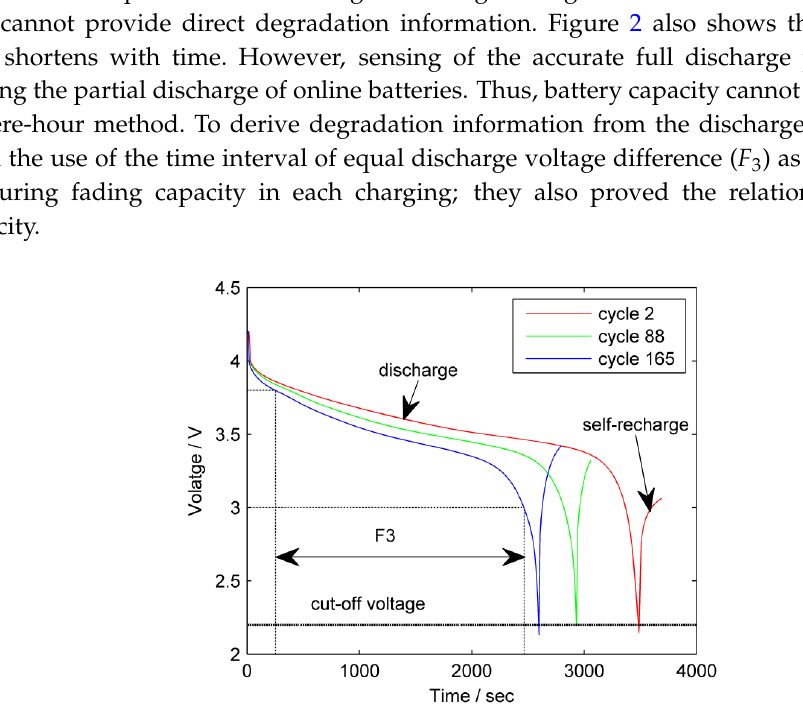
Figure 2. The third discharge-related feature extracted from the discharge charge step.